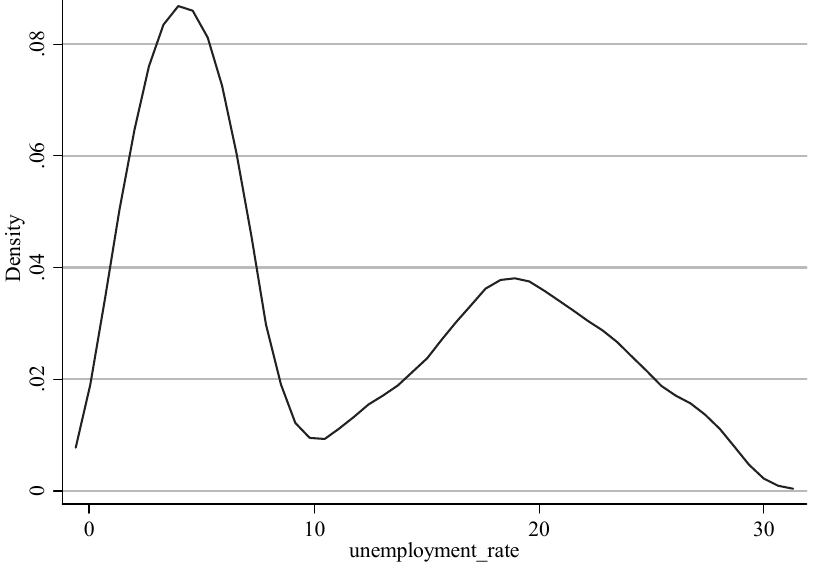
Figure 1 – Unemployment rate distribution by the 784 local labour systems in Italy. (density function estimated by Epanechnicov